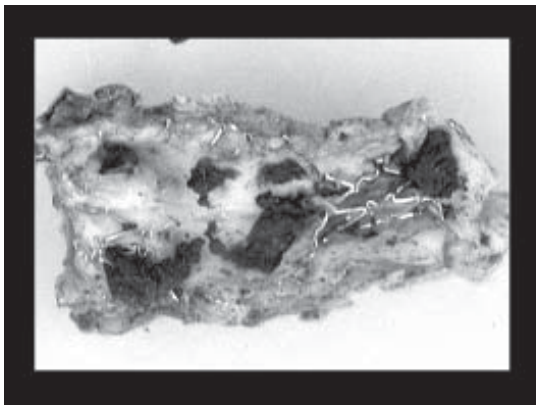
Fig. 7 - Incomplete endothelial development of a saphenous vein graft after implantation of a stent coated with rapamicin, with exposure of the metallic mesh of the stent in the vessel